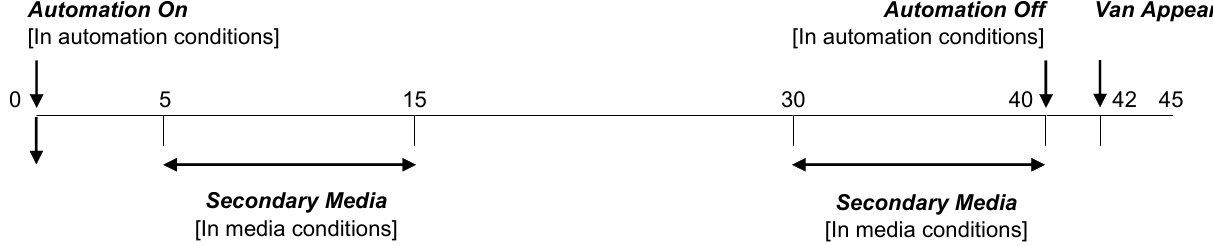
Figure 2. Timeline for simulated drive, by experimental condition.